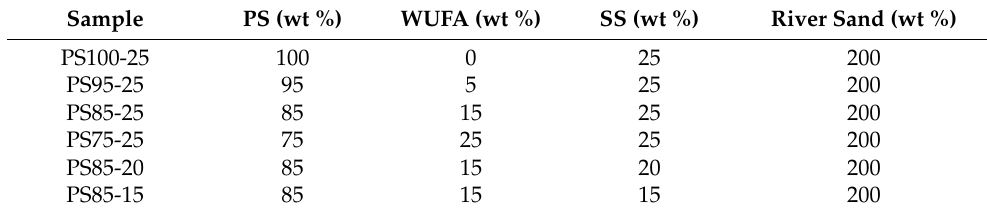
Table 2. Mix proportion of WUFA-PS and PS-based